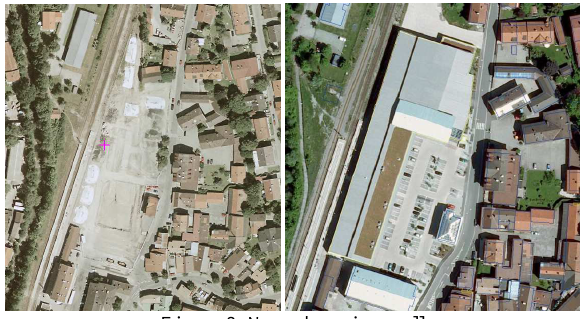
Figure 8. New shopping mall